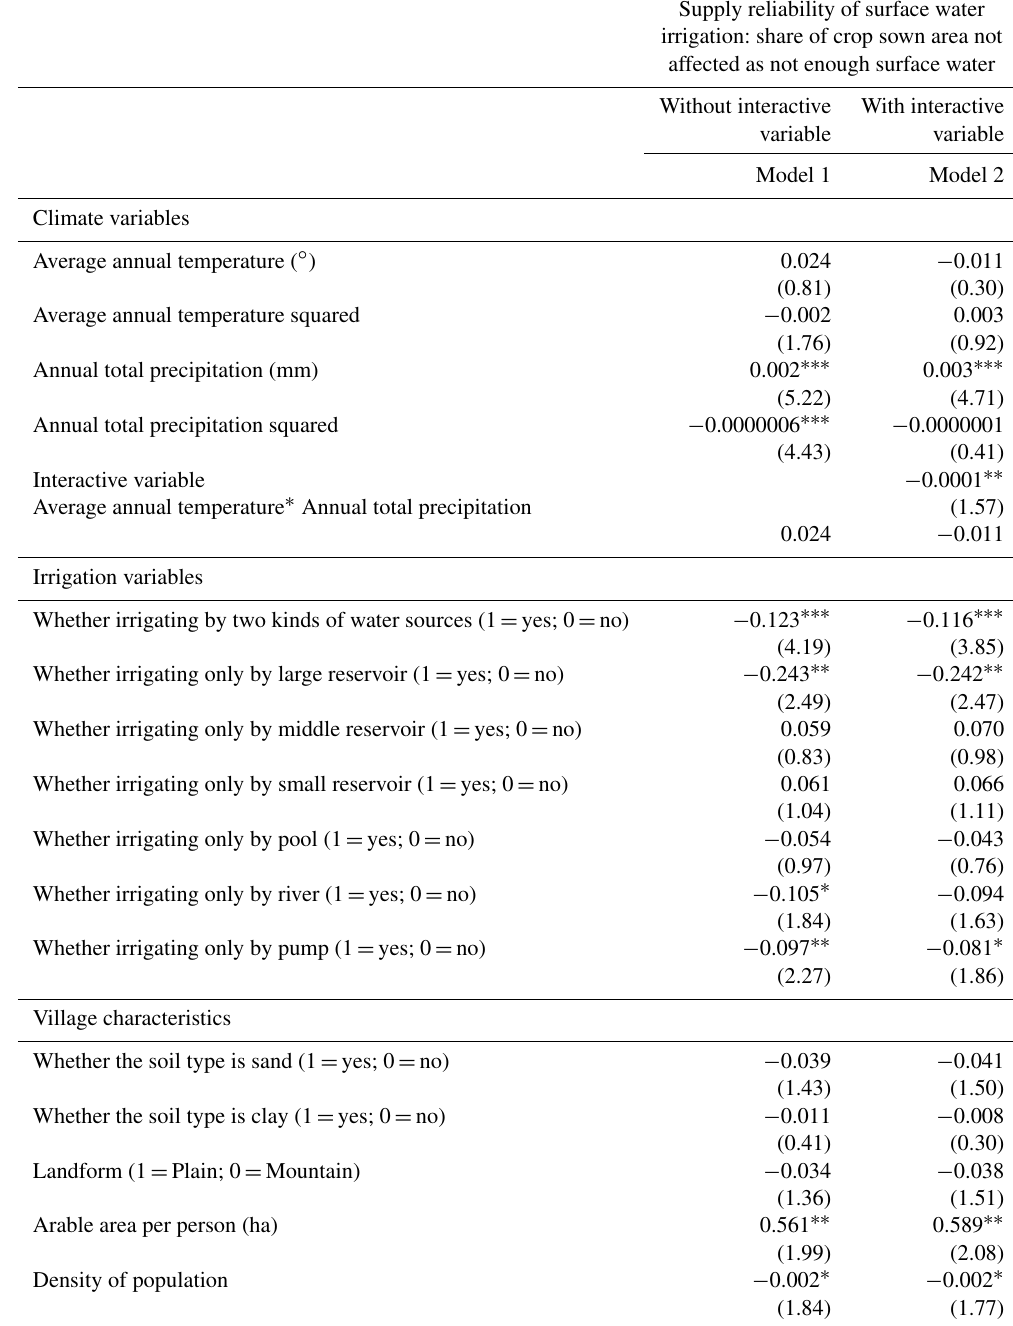
Table 3. Marginal effects of the determinants of the supply reliability of surface water irrigation from regression results of annual climate variables